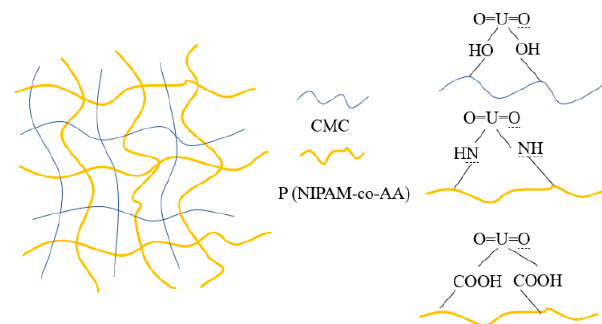
Figure 13. The proposed mechanism of the CMC/P (NIPAM co-AA) hydrogel interaction with UO 22+ .